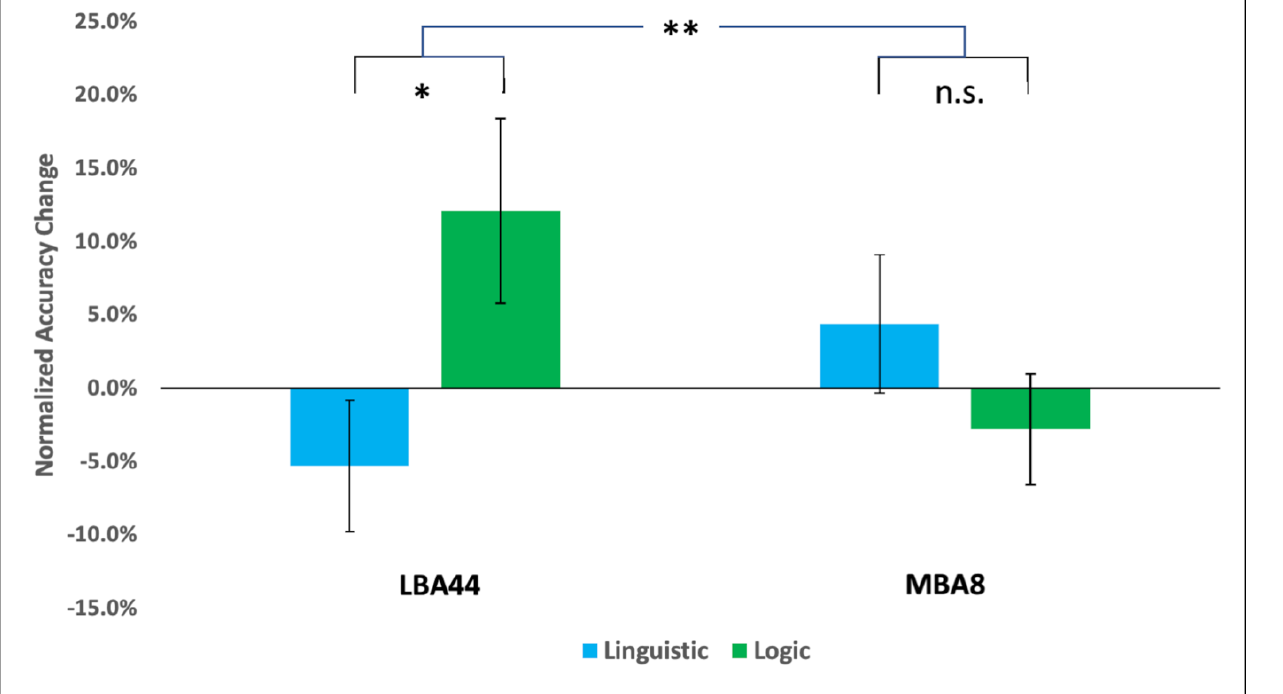
Figure 4. A priori analysis result: Percent accuracy change for linguistic (blue) and logic (green) reasoning after cTBS to Broca’s area (LBA44) ( left ) and MBA8 ( right ) (Error bars indicate standard error; “*” indicates p < 0.05; “**” indicates p < 0.01, “n.s.” indicates non-significant; see text for details).